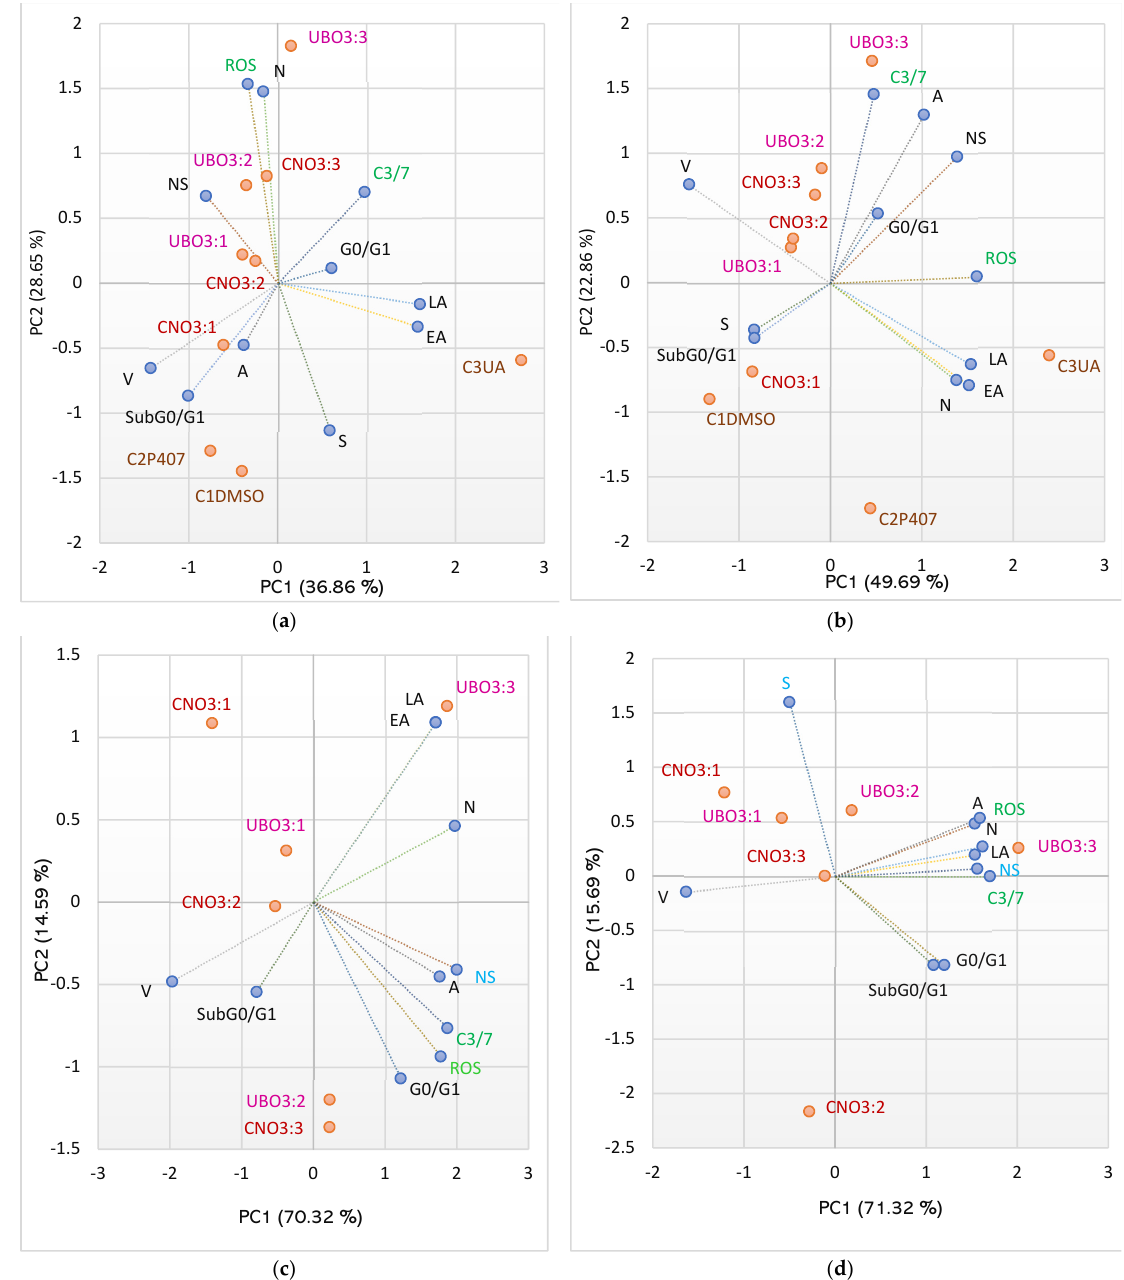
Figure 10. PCA-Correlation biplot ( a , b ) between mechanisms (enzymatic activity of caspase 3/7 and cellular oxidative stress) and processes induced by UBO, CNO, and controls (C1-DMSO, C2P407, and C2UA) in blood cells ( a ) and CLS-354 tumor cells ( b ). PCA-Correlation biplot ( c , d ) between mechanisms and induced processes only by oil samples (UBO and CNO) in blood cells ( c ) and CLS-354 cancer cells ( d ). UBO— U. barbata extract in canola oil, CNO—canola oil, [3:3, 3:2, 3:1] the ratio ( v/v ) between culture medium and oil sample. V—viability, EA—early apoptosis, LA—late apoptosis, N—necrosis, ROS—oxidative stress, C3/7—the enzymatic activity of caspase 3/7, A—